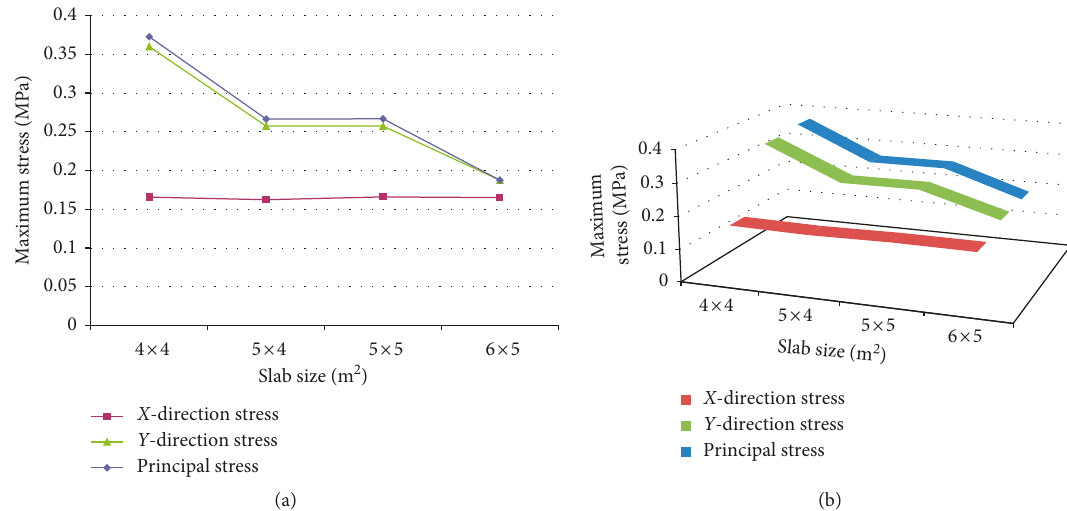
Figure 22: Variation of covered layer stress with slab size: (a) two-dimensional broken-line graph; (b) three-dimensional broken-line graph.